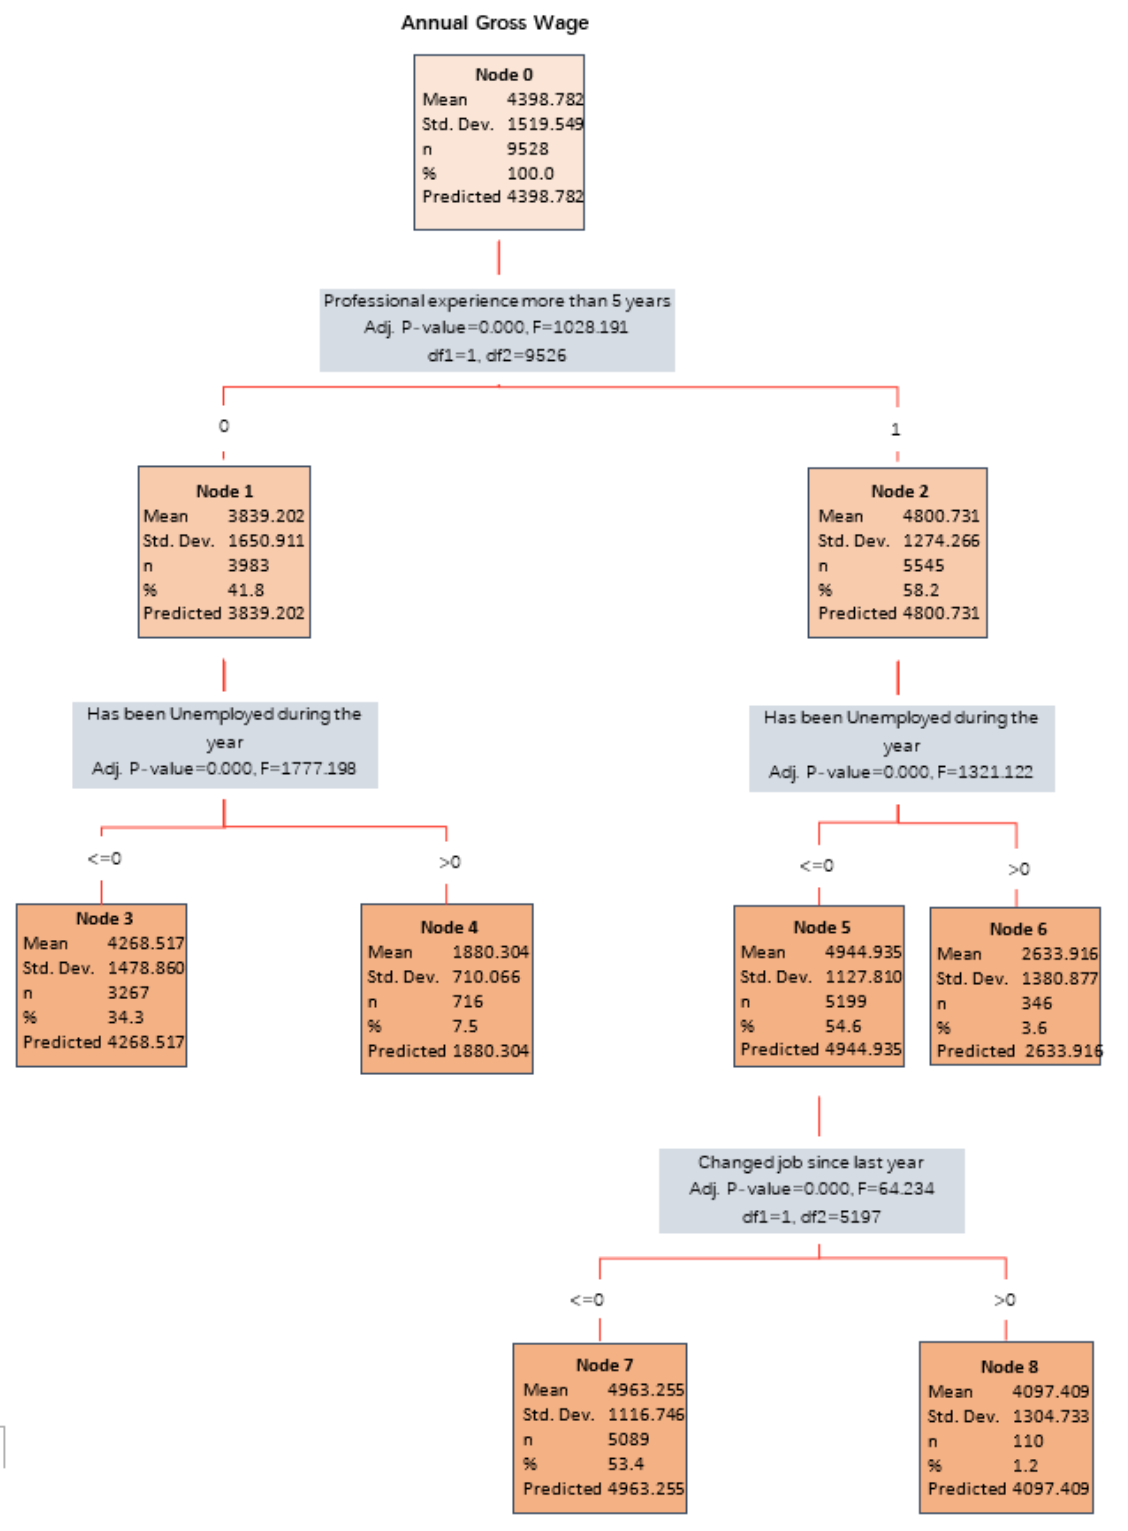
Figure 14. Internal divisions of precarious domestic workers. Data source: Eurostat EU-SILC (2020).